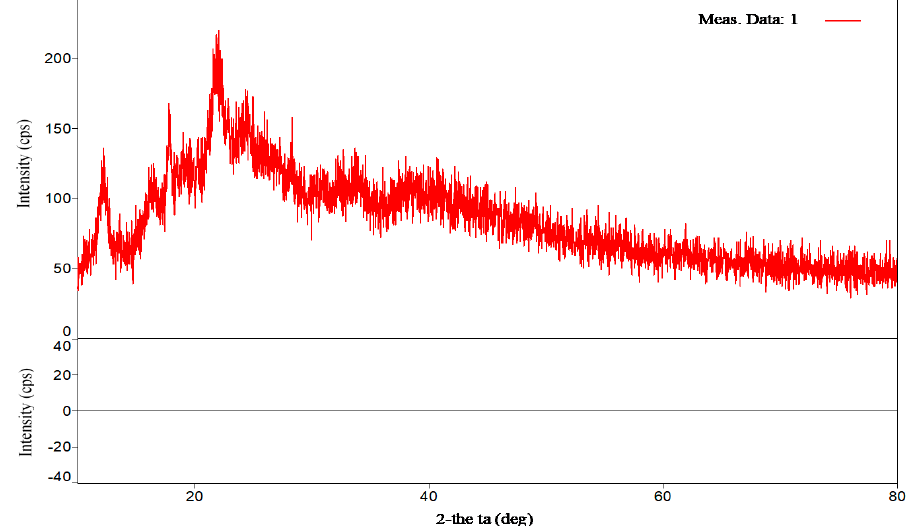
Figure 6. XRD pattern of 2:1 molar ratio inulin–TEOS adsorbent.